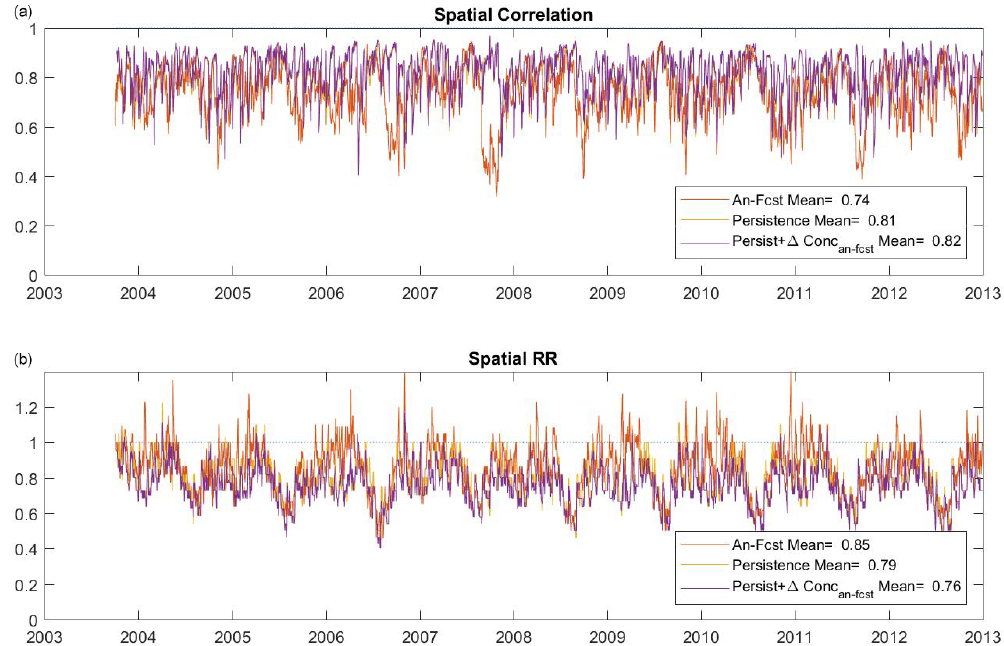
Figure 9. Time series of (a) spatial correlation and (b) spatial RR for the analogues-based forecast (model 1), the 7d long persistence (model 3), and the 7d long persistence in combination with the forecast of the concentration change (model